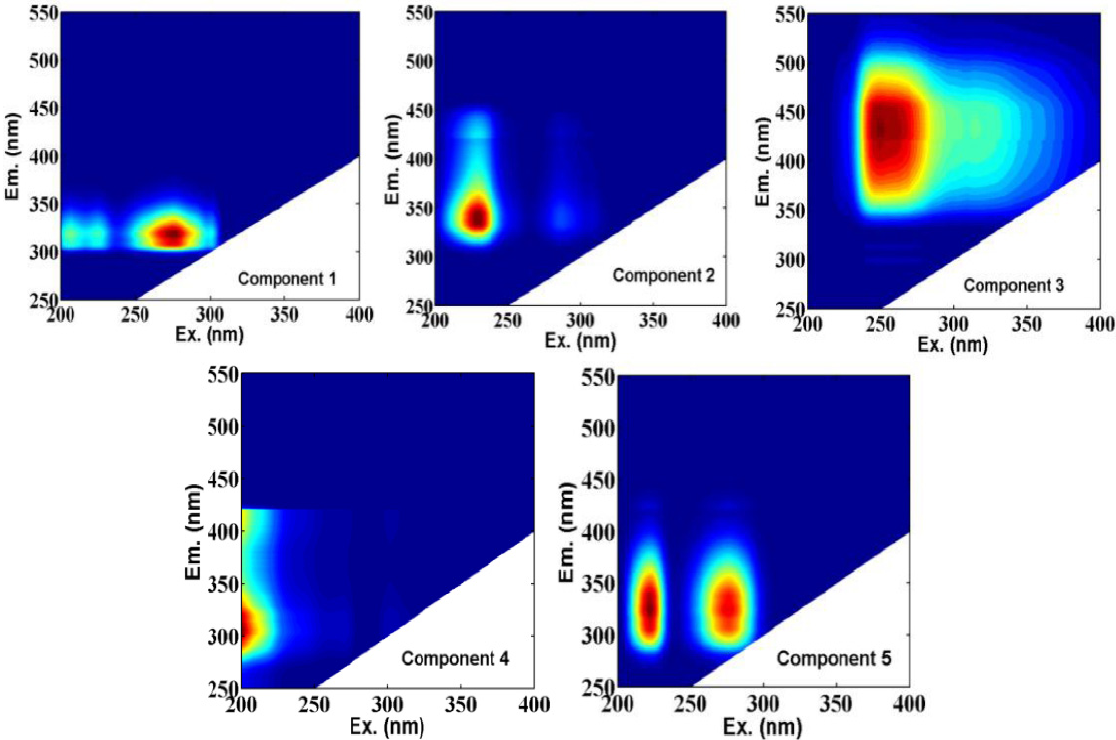
Figure 5. Five fluorescent components identified by the PARAFAC applied to the entire EEM data set of the study. C1: tryptophan-like substances, C2: amino acids, C3: humic-like component, C4: tyrosine-like substances, and C5: tryptophan- like substances.